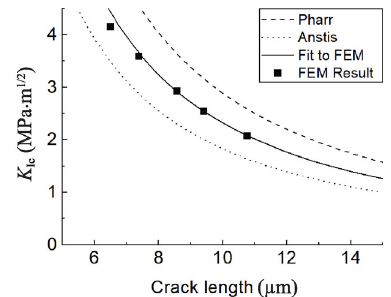
Fig. 17 Fracture toughness as a function of the length of a crack generated by instrumented indentation for different fitting constants (Jang and Pharr 0.025, Anstis e t al. 0.016, this study).